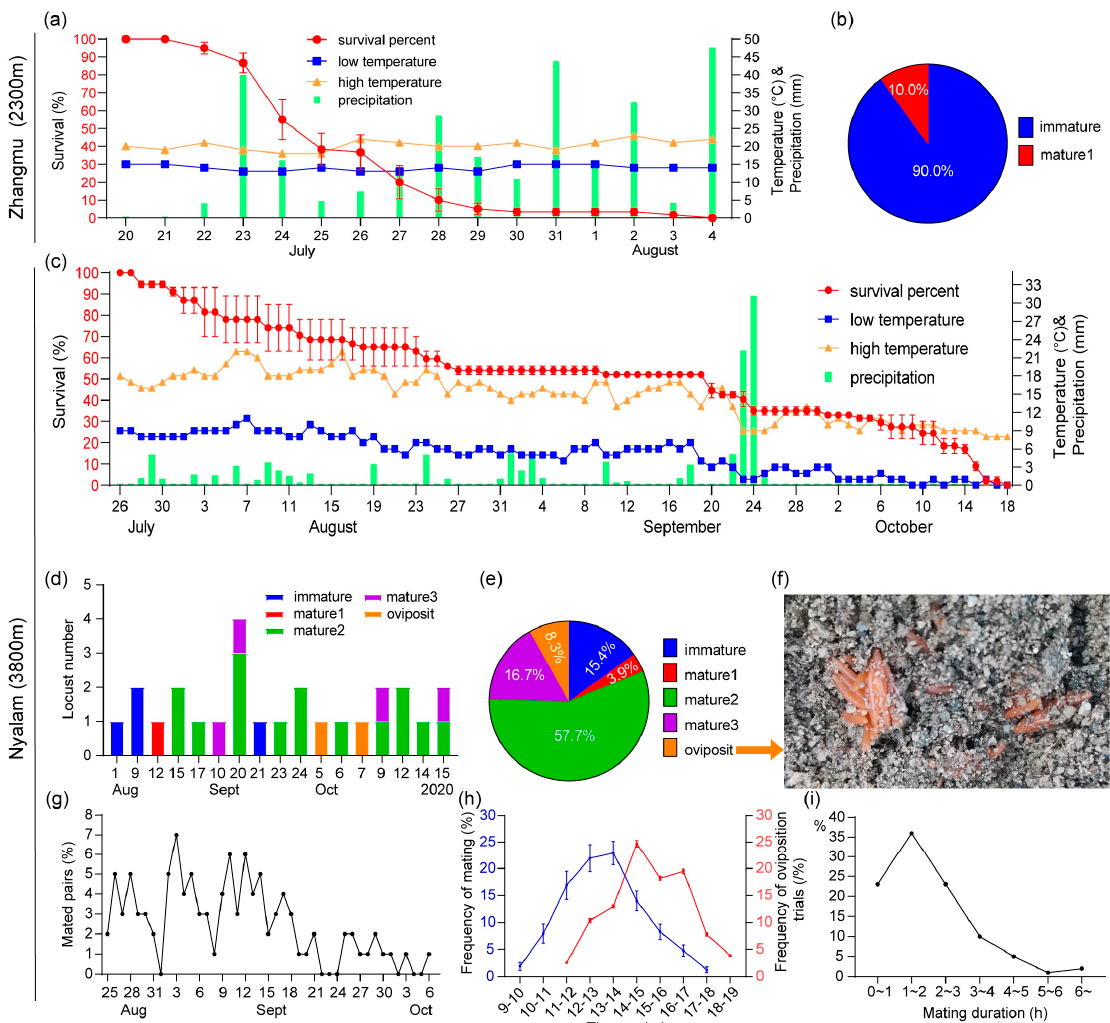
Figure 4. Cage field studies in Zhangmu (2300 m) and Nyalam (3800 m). Desert locust survival and weather conditions in Zhangmu ( a ) and Nyalam ( c ) in 2020 (the % of survival is the mean of survival percentages per cage). Percentage of maturation of females in Zhangmu ( b ). In Nyalam: Number ( d ) and percentage ( e ) of maturation status of females; eggs in the ootheca ( f ); daily mating rate of locusts ( g ); mating (left) and pre-oviposition behavior (right) rates ( h ); mating duration (%) ( i ).